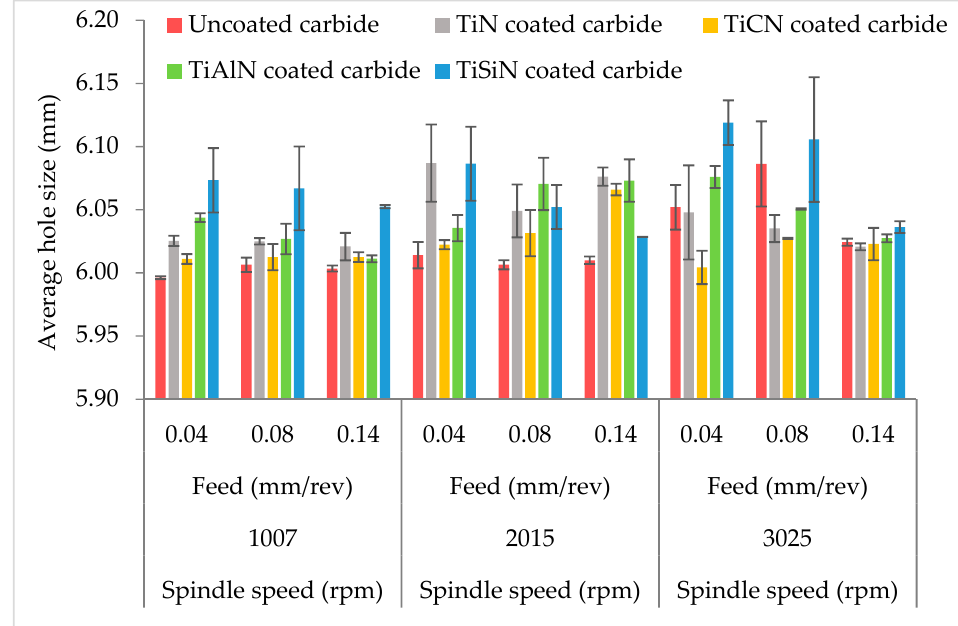
Figure 2. Deviation of holes from the nominal size for the uncoated and coated carbide drills .